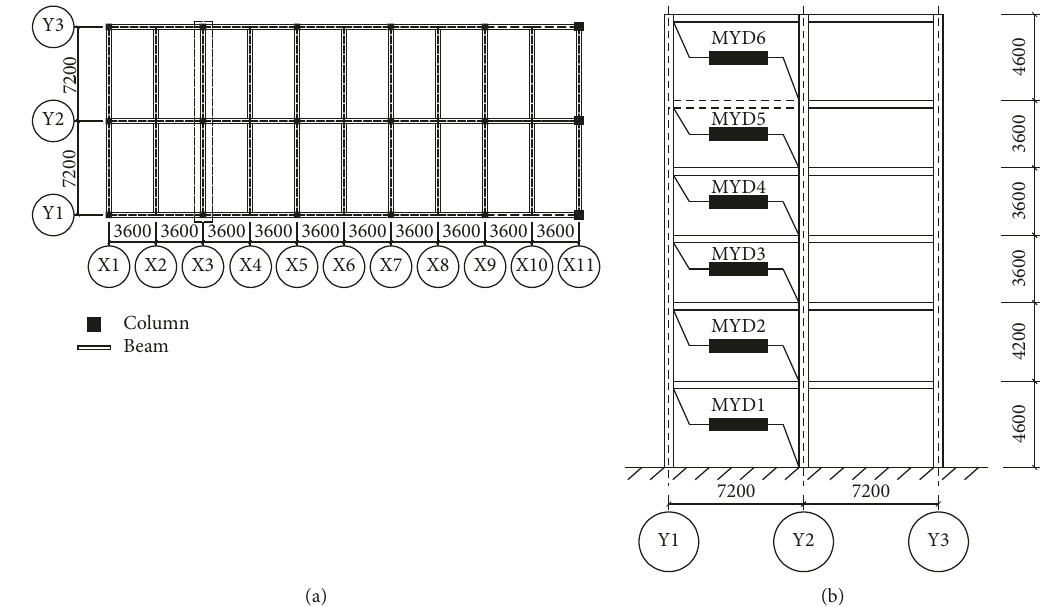
Figure 5: Structural plan and elevation (MYDs are installed in the Y direction) (unit: m ): (a) Structural plan; (b) structural